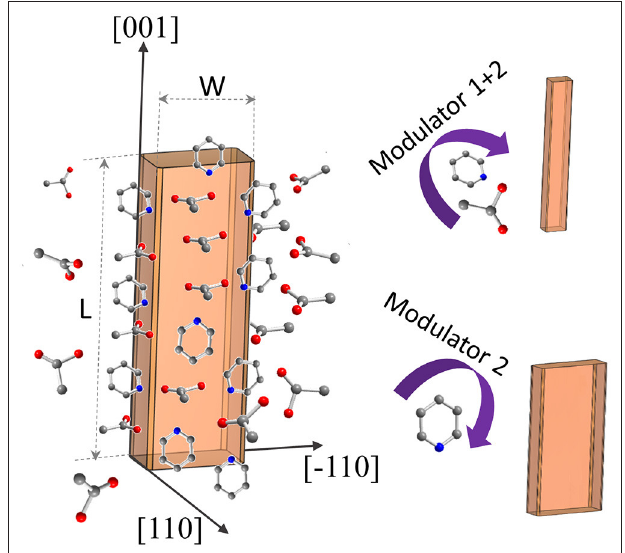
FIGURE 1 | Schematic representation of DUT-8(Ni) coordination modulation by acetic acid and